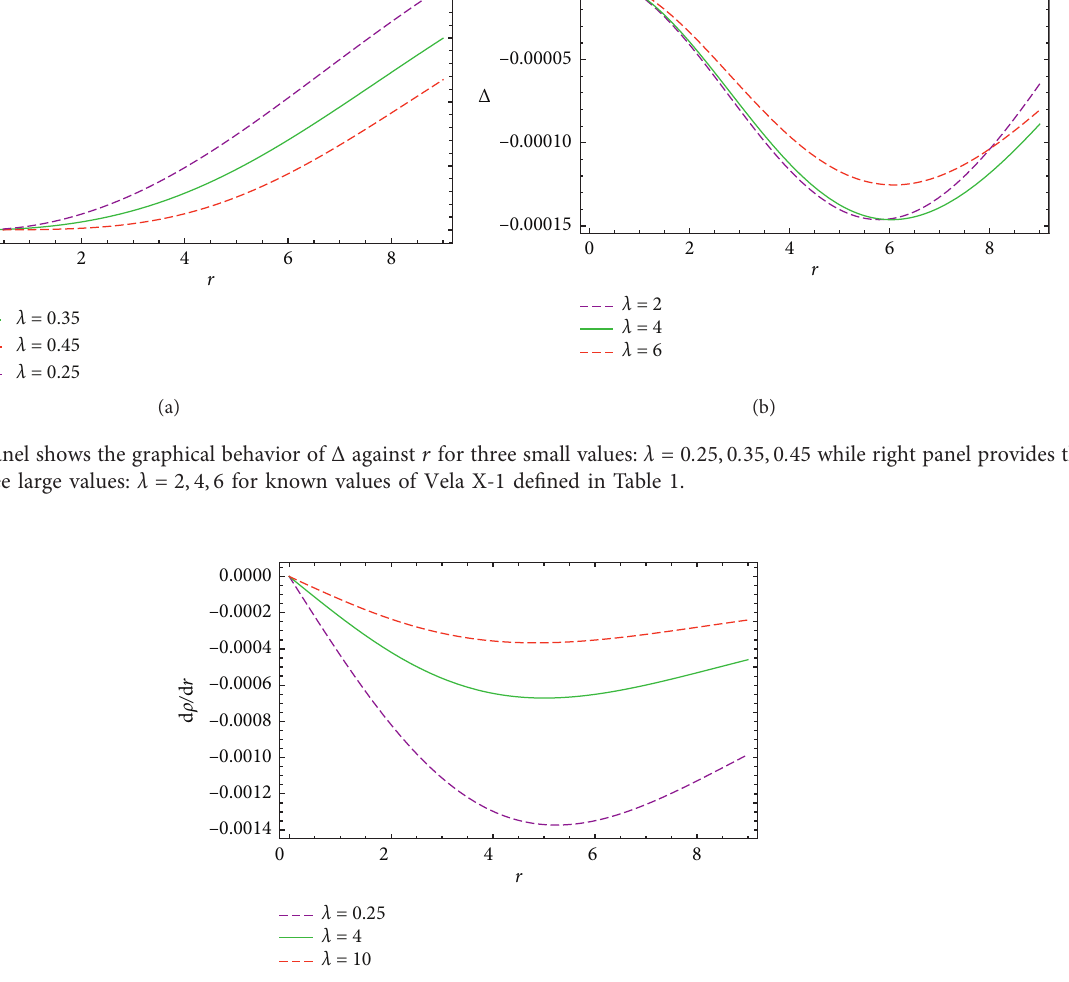
Figure 5: Graphical behavior of d ρ /d r against r for Vela X-1 under the values of known parameters for λ � 0 . 25 , 4 ,